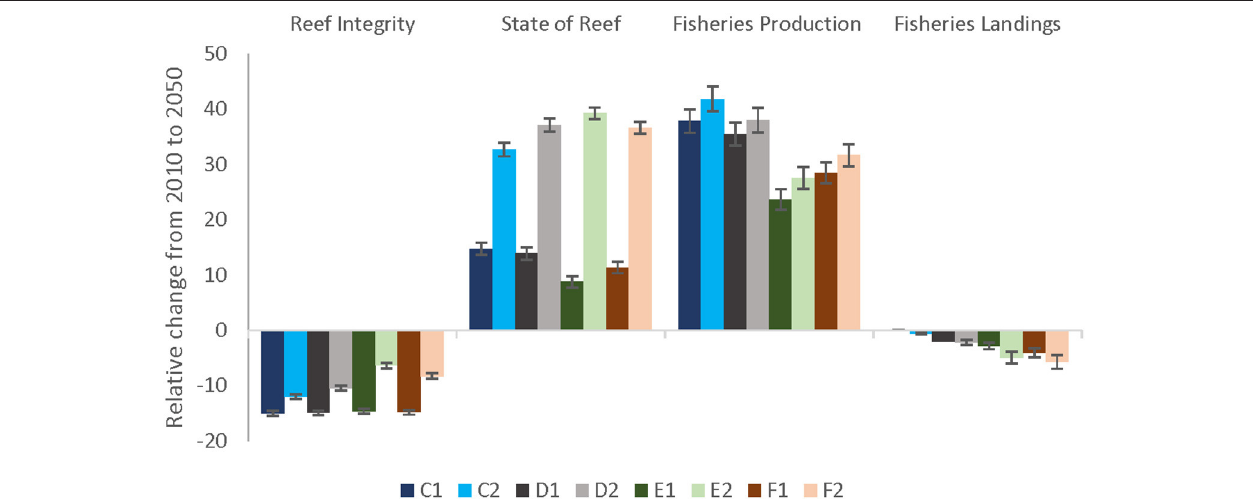
FIGURE 6 | Relative change (%) from 2010 to 2050 of each scenario including severe (darker bars) and less severe (lighter bars) climate change impacts. The blue bars (C1, C2) represent a future projection of Current Management practices, population growth, and severe (bleaching-related coral mortalities every other year; C1) and less severe (mortalities every 5 years; C2) climate-related stressors, respectively. The effects of local management are also shown under two climate scenarios: severe climate-related stressors in darker colors (denoted by a 1) and less severe stressors in lighter colors (denoted by a 2). The local management scenarios include: (D–gray bars) 10% no-take MPAs and low sediment mitigation, (E– green bars) 30% MPAs and strict sediment mitigation, and (F–red bars) 30% MPAs with an additional 20% reduced piscivore fishing effort and strict sediment mitigation.